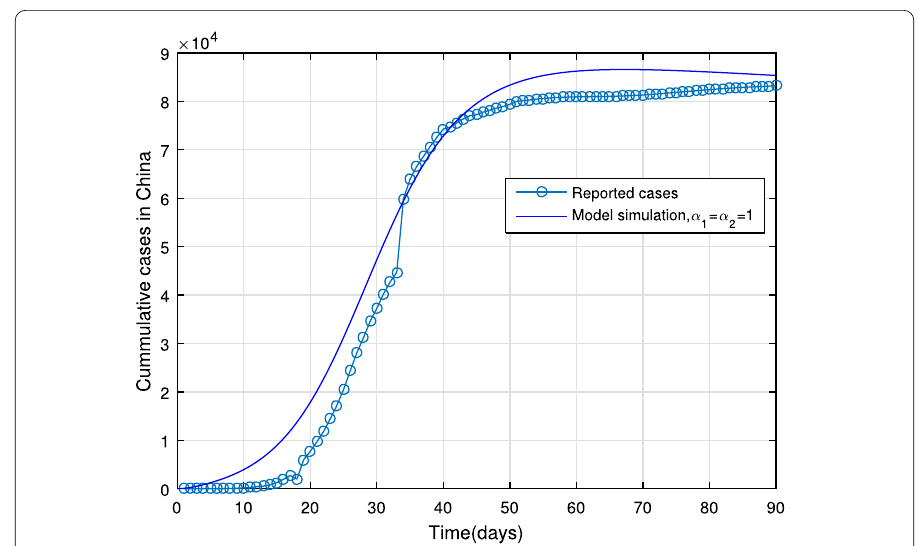
Figure 2 Reported number of COVID-19 cases in China versus model fit, α 1 = α 2 = 1